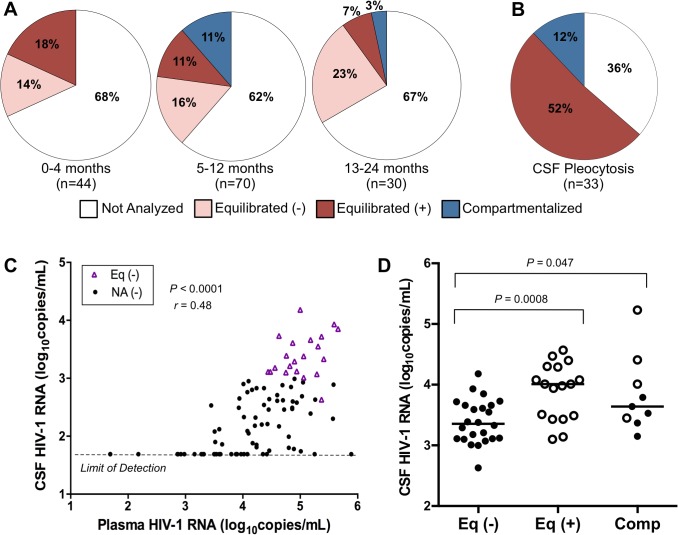
Correlates of CSF HIV-1 RNA levels, CNS inflammation, and CNS phylogenetic state.(A) Pie charts grouping the samples by days p.i. and showing the percentage of samples in each phylogenetic state as a function of time: 0–4 months (‘acute’), 5–12 months (‘early’), and 13–24 (‘established’). States represented include: Not Analyzed by SGA, due to CSF viral load <1,000 copies/ml; Equilibrated (−), CSF WBC <10 cells/μl; Equilibrated (+), CSF WBC ≥10 cells/μl; and Compartmentalized. We used a cut-off of 10 WBC/μl to define a state of substantial CSF pleocytosis because this is two-times the upper limit of normal value of CSF WBC (0 to 5 cells/μl) [22] ensuring that the measured pleocytosis was a robust marker for an inflammatory response. (B) Pie chart showing the percent of samples in each phylogenetic state exhibiting substantial CSF pleocytosis (CSF WBC ≥10 cells/μl). (C) Relationship between plasma and CSF HIV-1 RNA concentrations for not analyzed samples with minimal pleocytosis (NA (−); CSF WBC <10 cells/μl) and equilibrated samples with minimal pleocytosis (Eq (−), CSF WBC <10 cells/μl). Spearman’s rank correlation coefficient and P-value are indicated. Samples with undetectable CSF HIV-1 RNA (<50 copies/ml; limit of detection) were not included in the correlation analysis. (D) Relationship between CSF viral loads for equilibrated with minimal pleocytosis (Eq (−); CSF WBC <10 cells/μl); equilibrated with marked pleocytosis (Eq (+); CSF WBC ≥10 cells/μl); and compartmentalized (Comp) samples. Significant P values (Mann-Whitney Test) comparing relationships between groups are indicated. Samples with evidence of marked pleocytosis (CSF WBC ≥10 cells/μl) are indicated using open circles, while samples with minimal to no pleocytosis are indicated by solid circles.